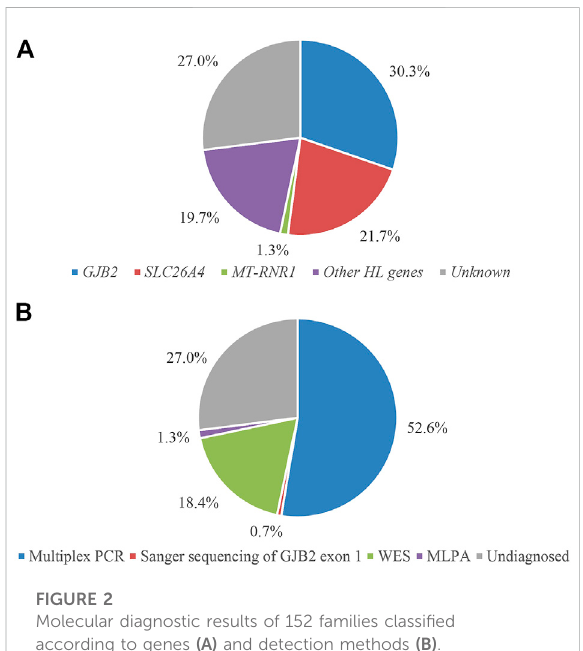
FIGURE 2 Molecular diagnostic results of 152 families classi fi ed according to genes (A) and detection methods (B)